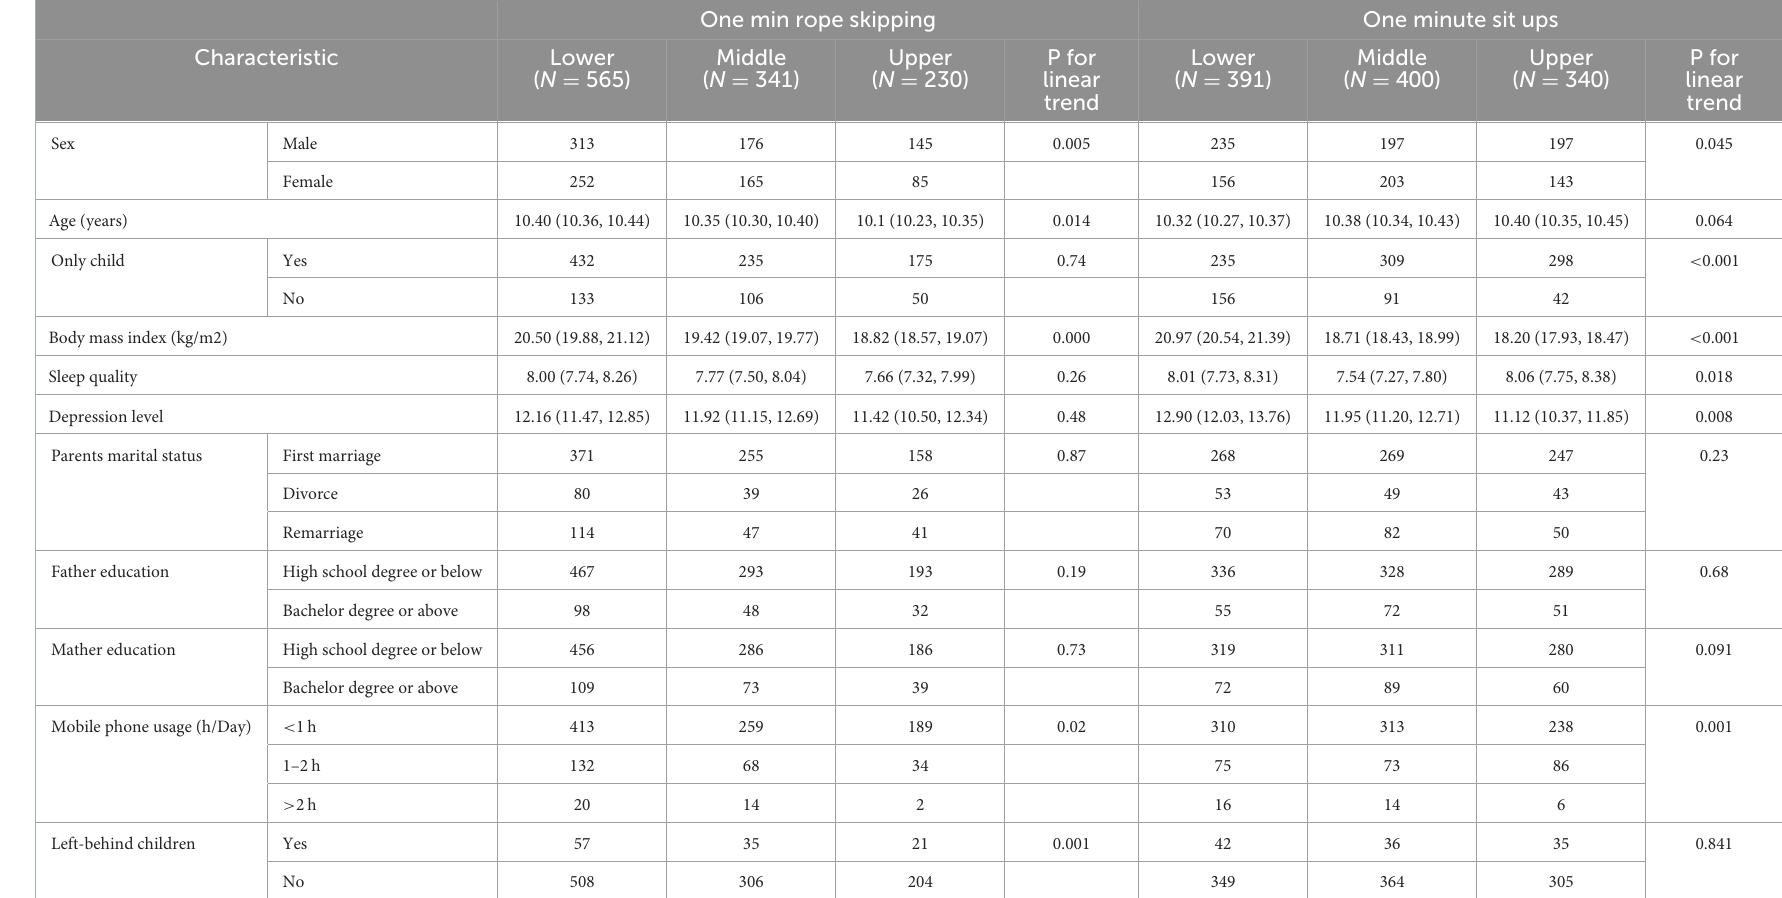
TABLE 5 The participants’ baseline characteristics, according to categories of 1-min jump rope and 1-min sit-ups. One min rope skipping One minute sit